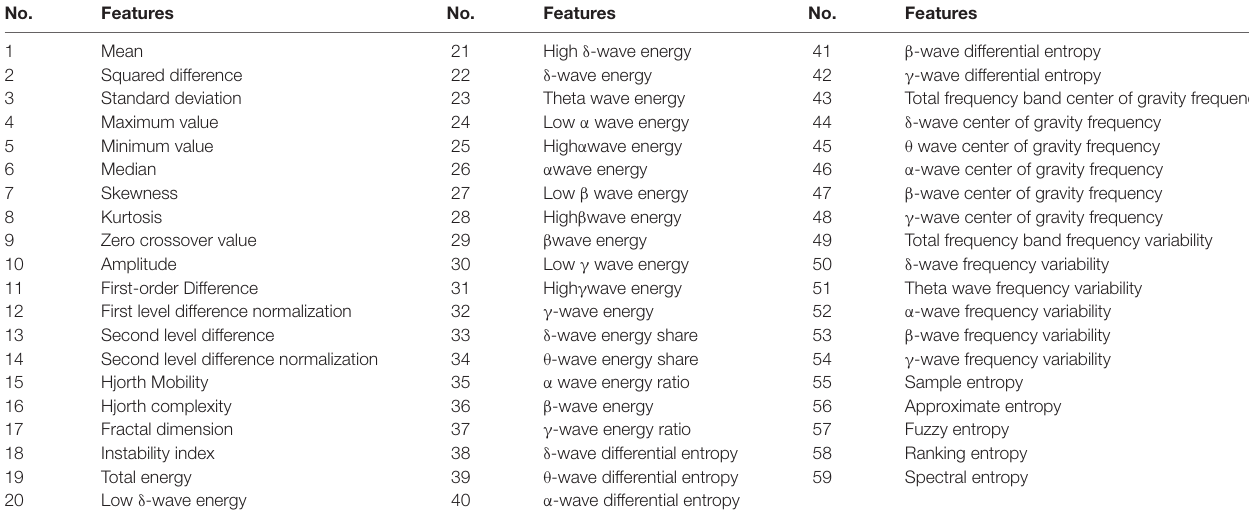
TABLE 1 | Basic characteristics of EEG